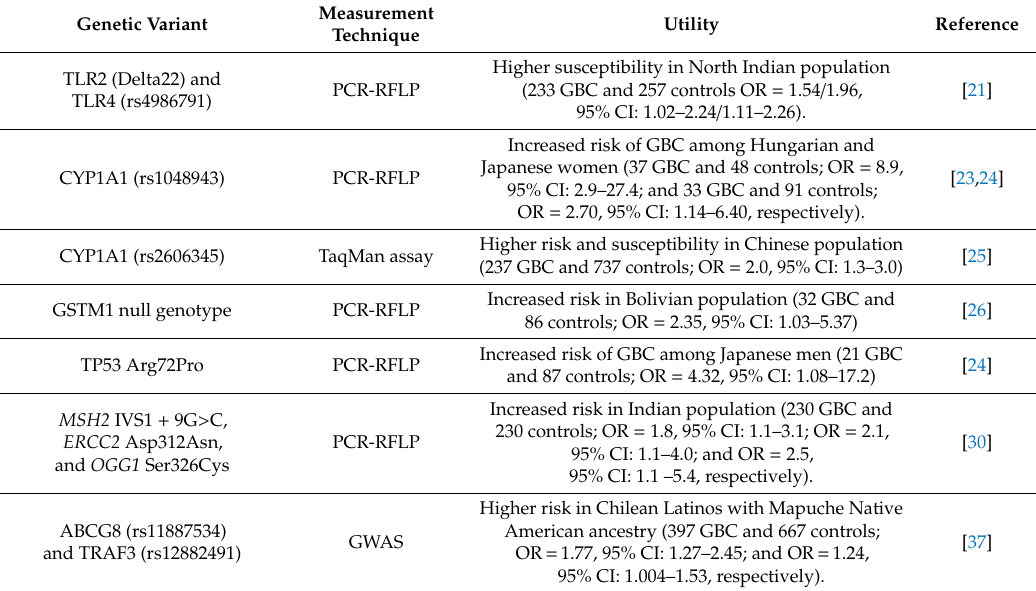
Table 1. Biomarkers of genetic susceptibility in gallbladder